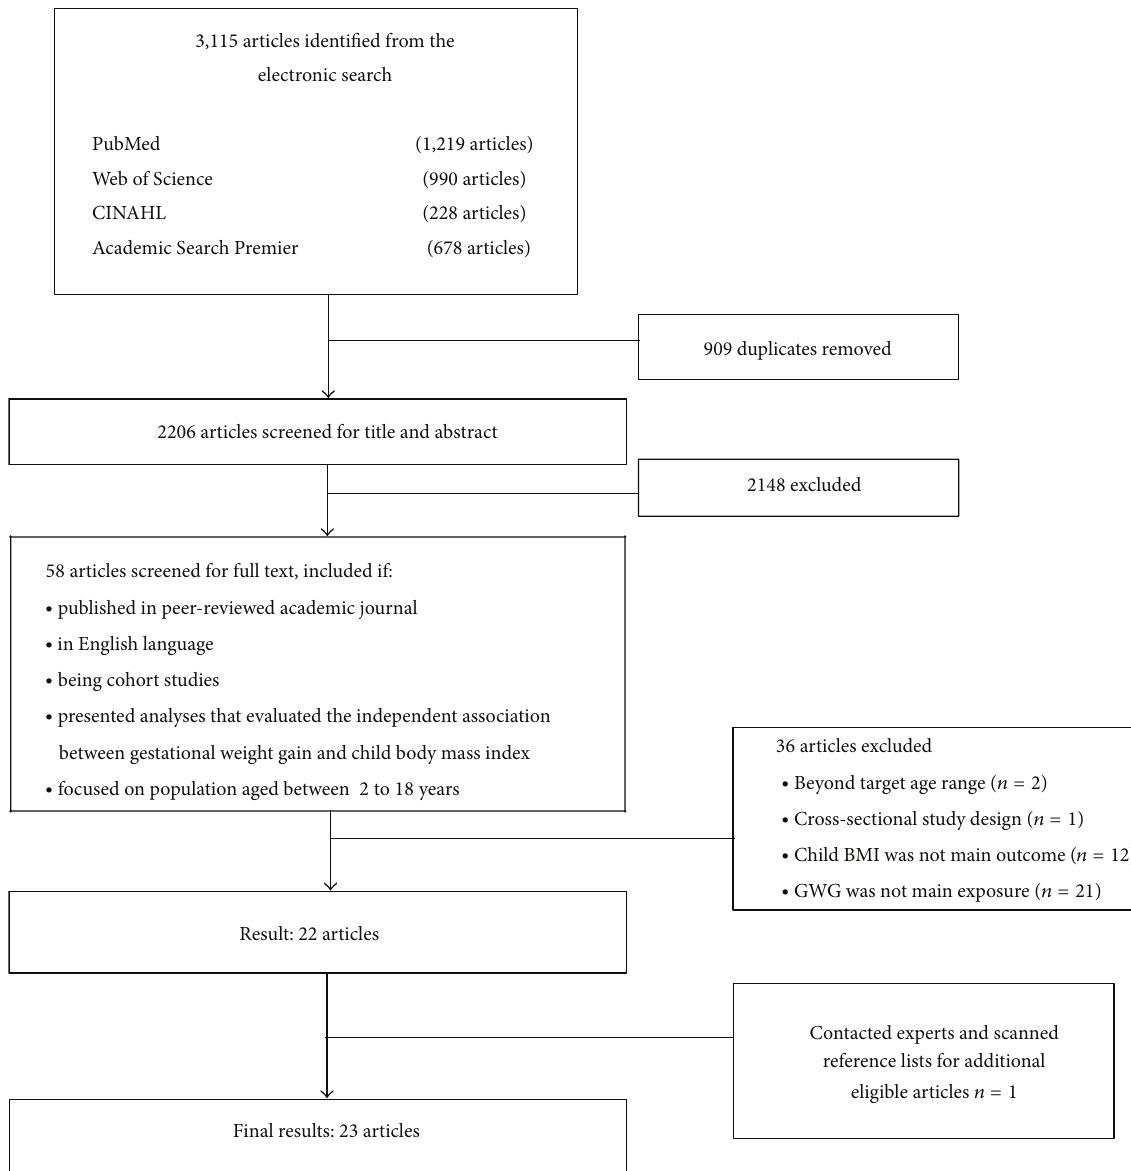
Figure 1: Flow diagram of study selection